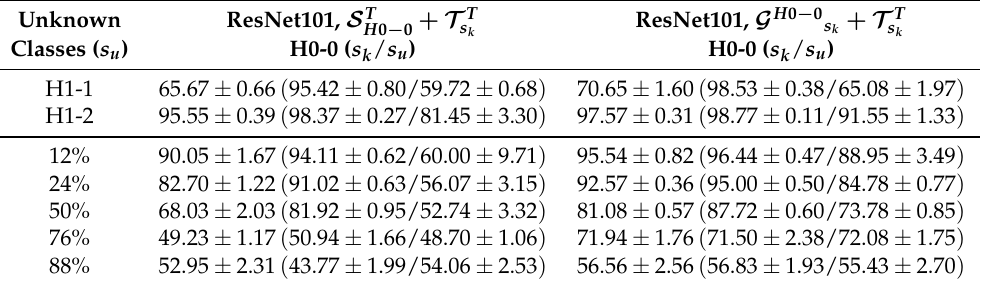
Table 9. Experiments to support Q2 analogously to Table 8, but using ResNet101. In this case, the lower and upper bounds are 58.74 and 98.76,